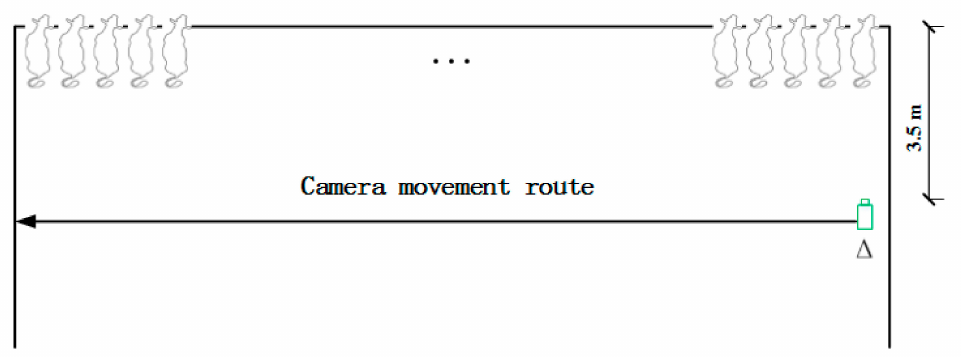
Figure 2. Layout of the